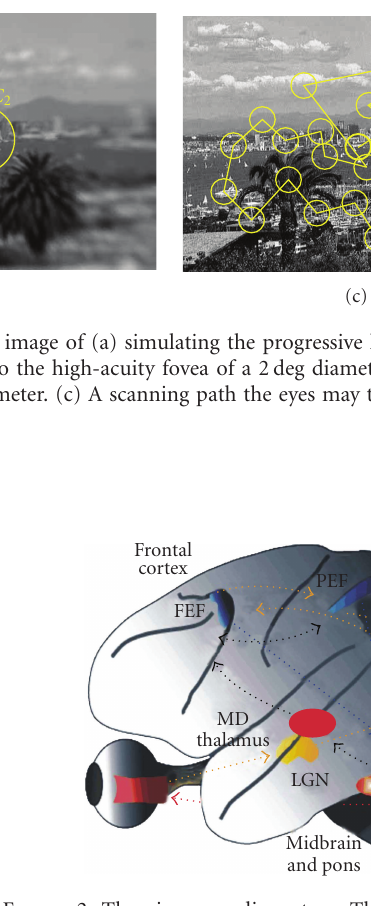
Figure 2: The visuosaccadic system. The course of events is the following. (1) Fixations ( ∼ 300ms). When eyes complete a saccade, visual information is acquired and sent via LGN to V1 and higher cortical areas including FEF and PEF (yellow paths). The next saccade’s target is selected in FEF/PEF and its position is calculated in SC (blue paths) and the oculomotor command (OC) is prepared (Pons). However, before the saccade is executed, a copy of OC is sent via MD of Thalamus to FEF/PEF (black paths) to shift the receptive fields of the current fixation landmarks to the receptive fields of their future positions centered at the impending saccade’s target. (2) Saccades ( ∼ 30ms). The OC executes the eyes’ saccade with the motor neurons (red paths). The shift of receptive fields (starting ∼ 50 ms before the saccade onset and ending ∼ 50ms after the saccade landing) gives access to the upcoming saccade’s target before eyes arrival, integrating objects’ features between fixations and maintaining stability of